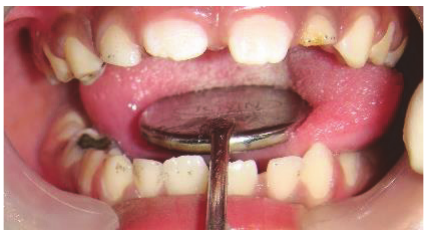
Figure 2: Preoperative photograph (Case 1 ).